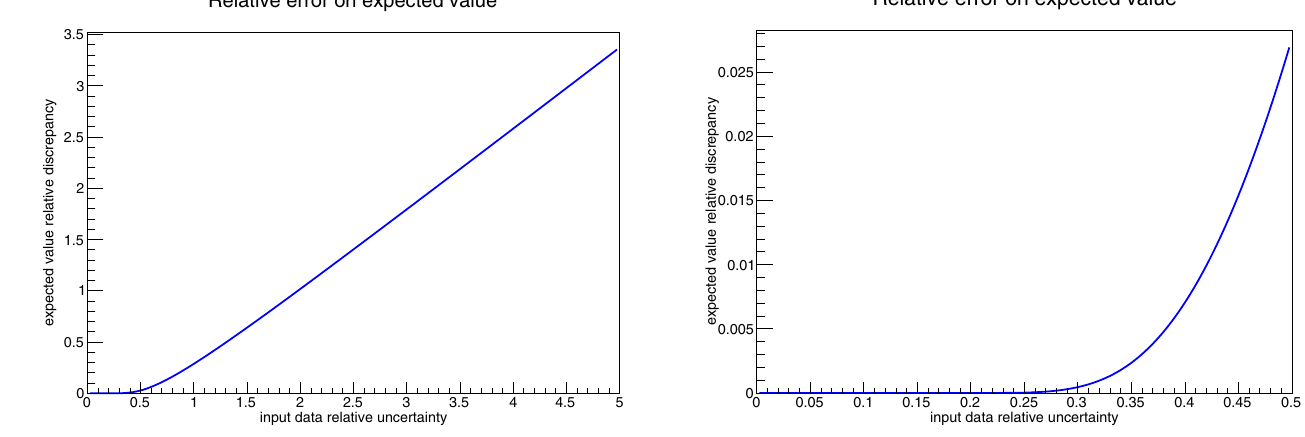
Fig. 2. Relative error on